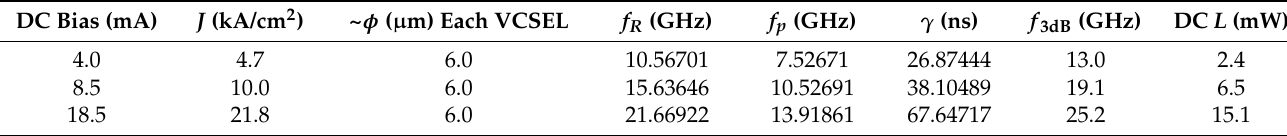
Table 1. Extracted |S21| fitting parameters for the Kapalua triple 980 nm VCSEL with ϕ ~ 6 μ m.